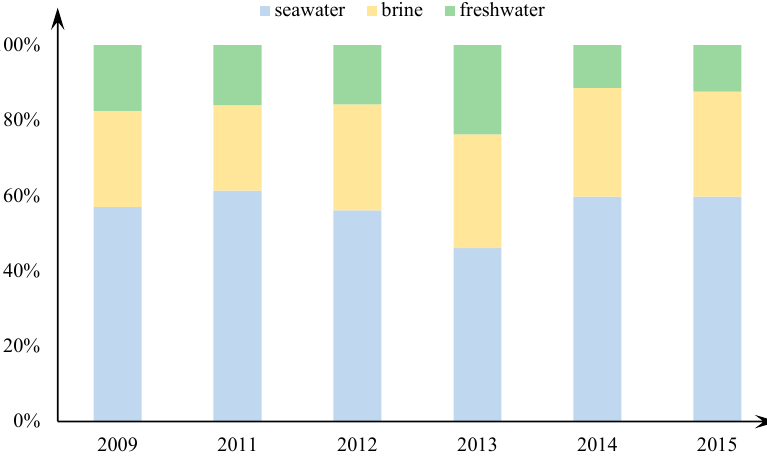
Figure 6. Average mixing proportions of all water samples for the entire mine from 2009 to 2015.